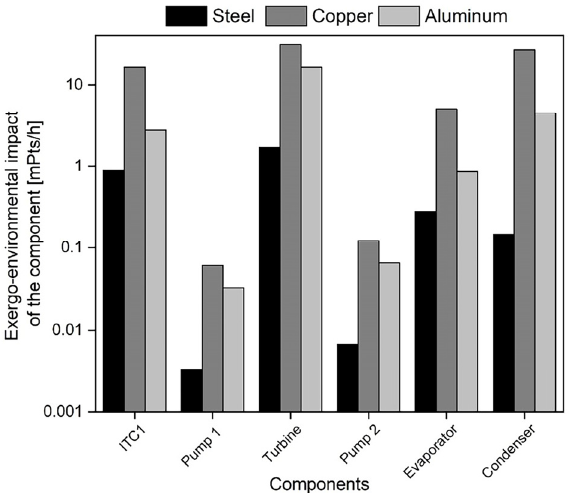
Figure 10. Exergo-environmental impacts of the components with respect to the materials under